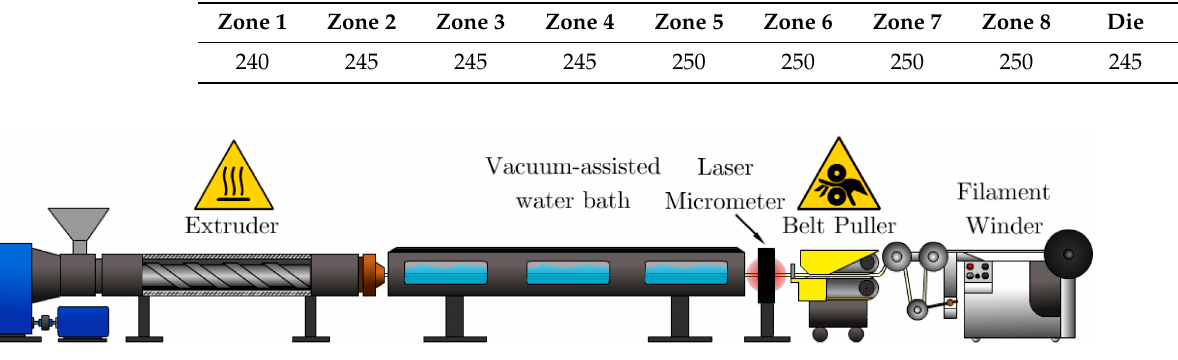
Figure 4. Scheme of the components for the filament